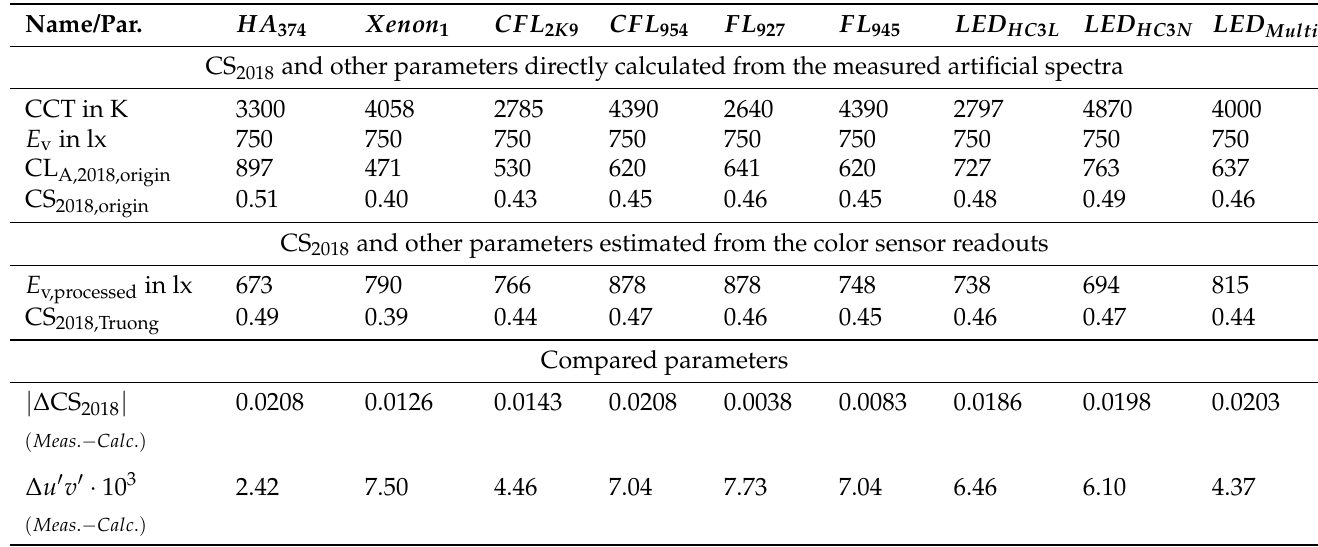
Table 4. Comparison between the color sensor’s CS predictions (CS 2018,Truong ) and Rea et al.’s original model (CS 2018,origin ) for a second set of artificial light sources not included in the training data. Again, the vertical illuminance was assumed to be 750lx, and the CS 2018,origin measurement accuracy is ± 8%. The annotation “ ( Meas . − Calc . ) ” in the “Compared parameters” section of the table serves as an indication that the accuracy estimate | ∆ CS 2018 | , as well as the colorimetric prediction error ∆ u (cid:48) v (cid:48) for a given light source are determined by comparing the corresponding quantities derived from the performed radiometric measurements (i.e., “ Meas .”) to those calculated from the adequately processed sensor readouts (i.e., “ Calc .”) as described in this